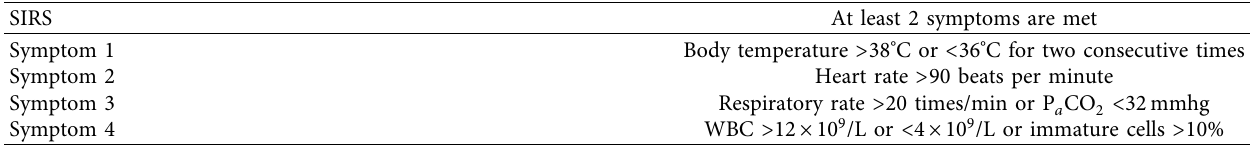
Table 2: Diagnostic criteria for SIRS.